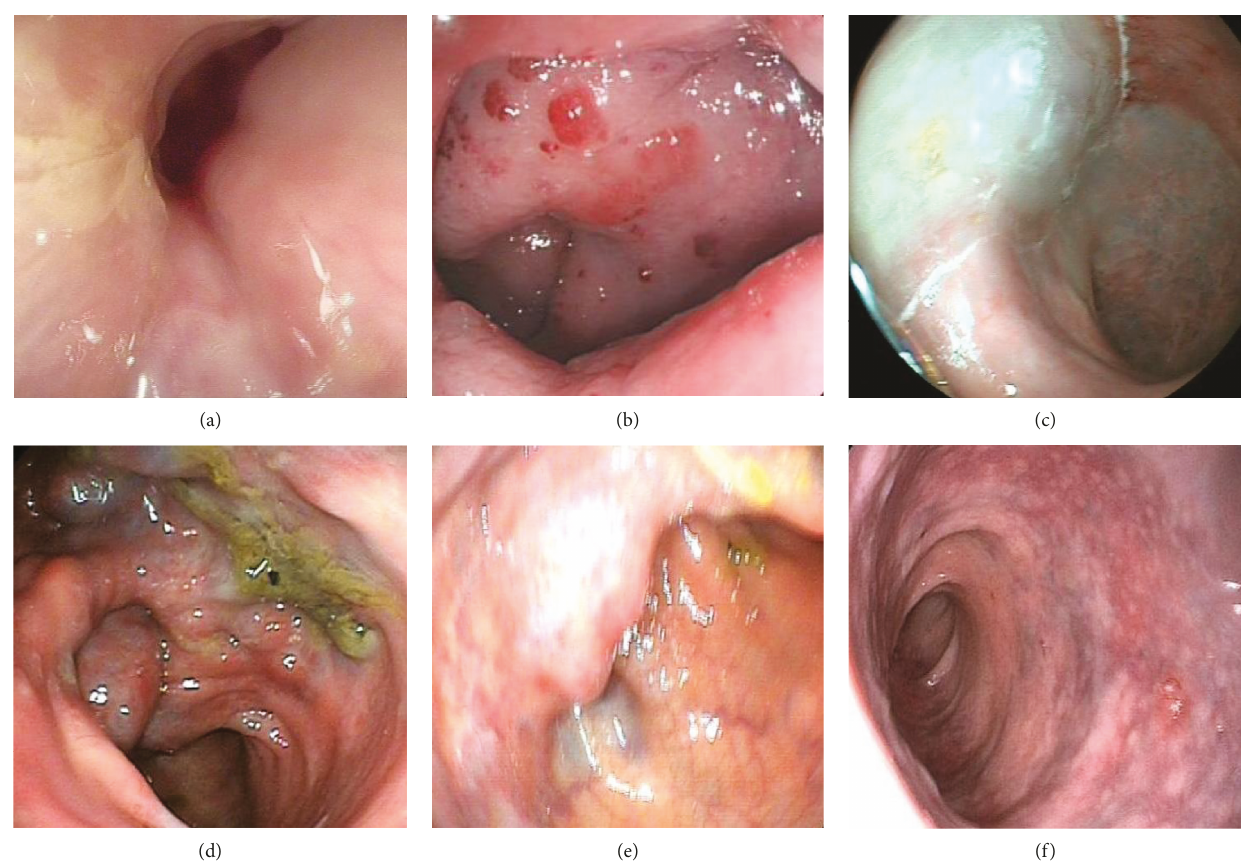
Figure 2: Colonoscopic fi ndings of DCHR. (a) Normal. (b) Congestion, swelling, and bleeding. (c) Bluish swelling. (d) Enlarged serpentine vessel. (e) Submucosal nodule. (f) Bluish and purple change.